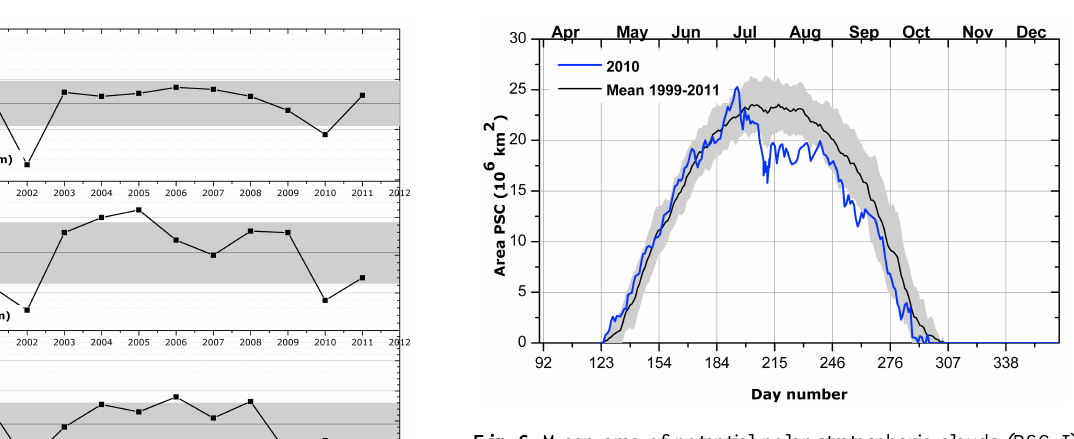
Fig. 6. Mean area of potential polar stratospheric clouds (PSC-I) formation based on ECMWF operational analysis truncated to T106 horizontal resolution (1.125 ◦ × 1.125 ◦ ) for the period 1999–2011 (black line). The grey area represents one standard deviation. The area for the year 2010 is shown in blue line.